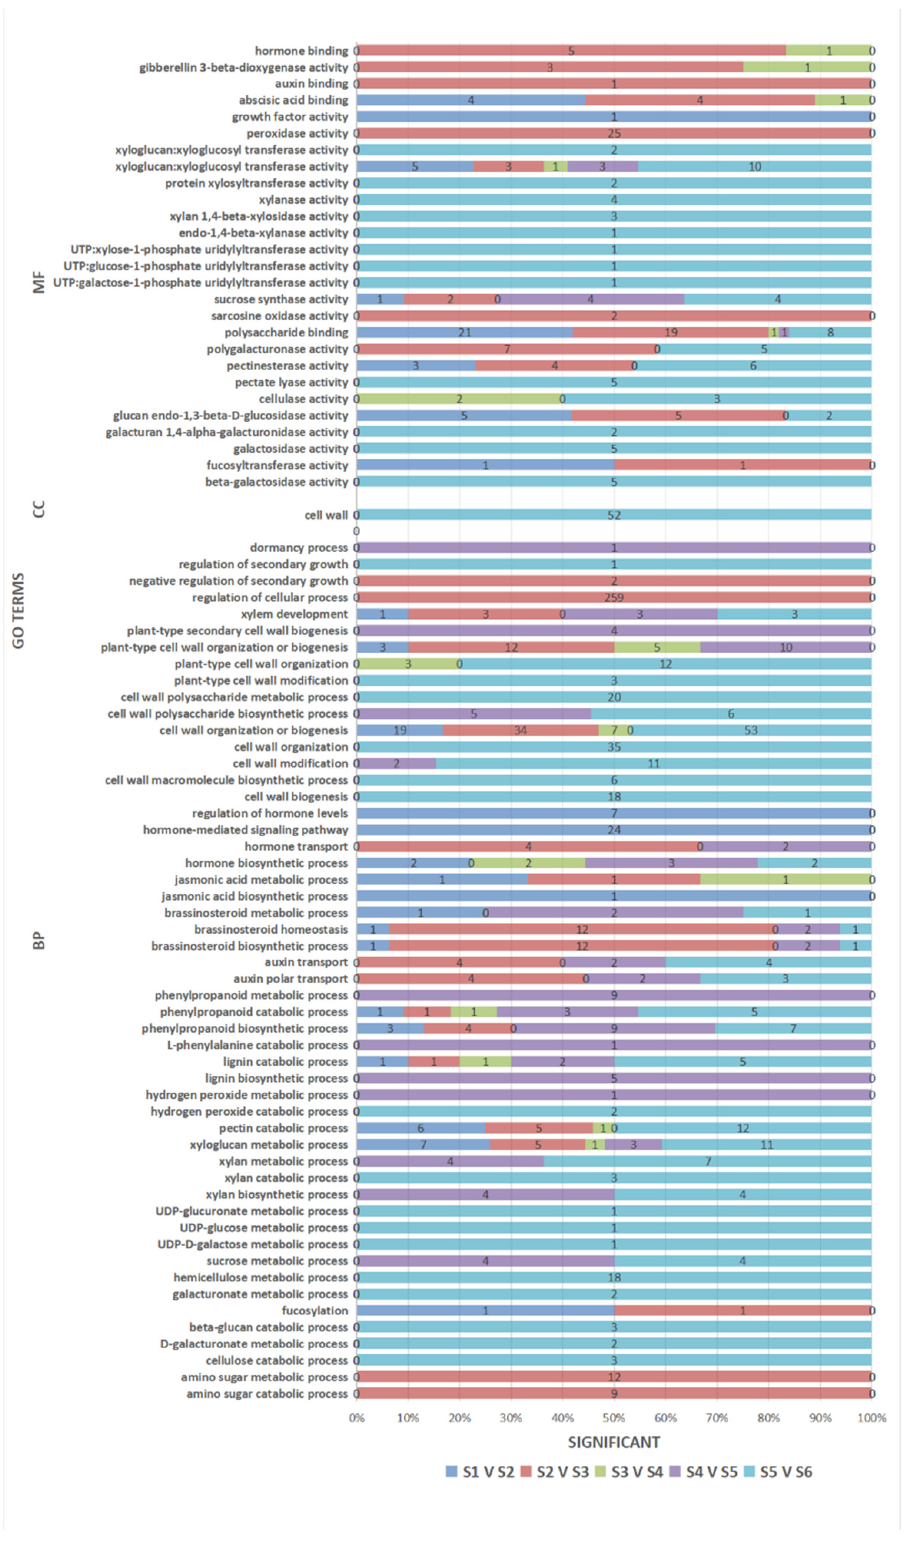
Figure 6. Distribution of the Gene Ontology (GO) terms associated with xylem development in “Shanxin” poplar after an enrichment analysis of the downregulated DEGs during the seasonal change. As in Figure 5, the GO terms in the three major GO ontologies are shown on the left, and the specific sample comparisons are color-coded. BP: Biological process, MF: Molecular function and CC: Cellular component. The number represents the number of enriched genes.